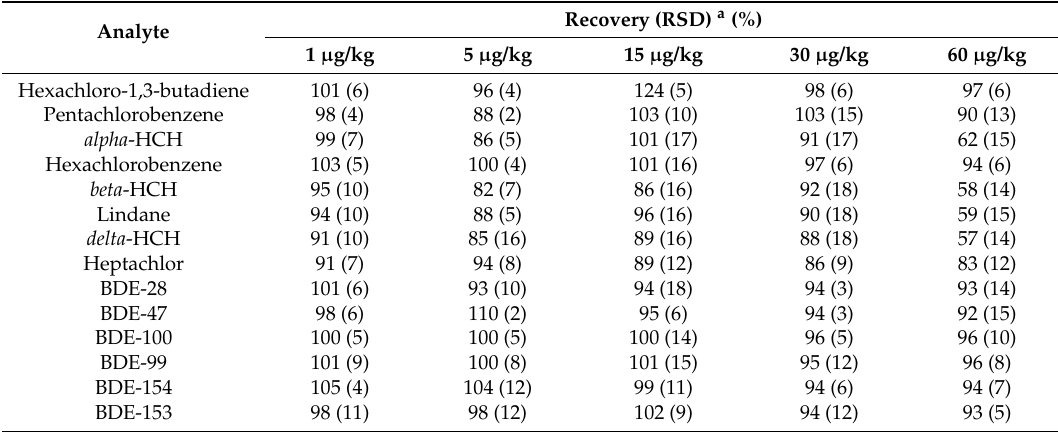
Table 4. Recoveries and RSDs of the test analytes from the spiked chub homogenate.